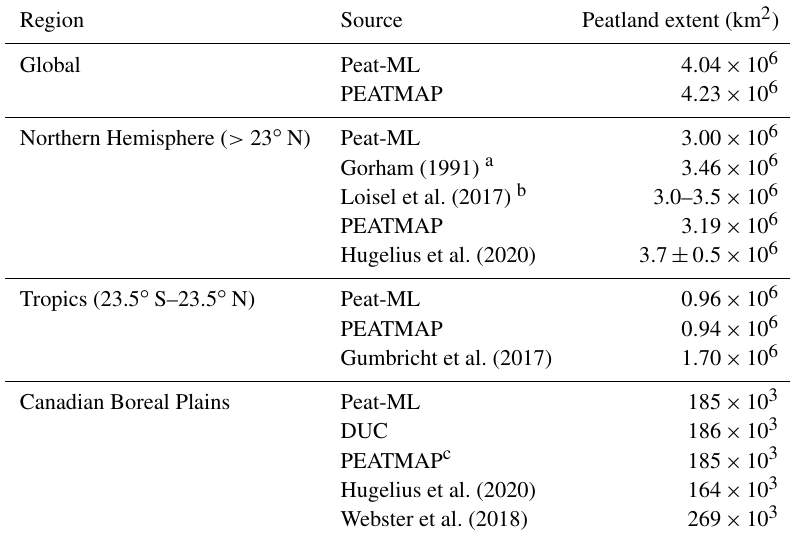
Table 3. Peatland extents as estimated by Peat-ML alongside other literature